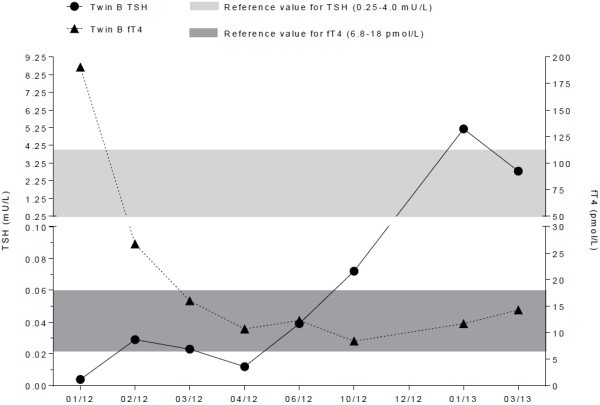
Timeline of TSH and fT4 for twin B.